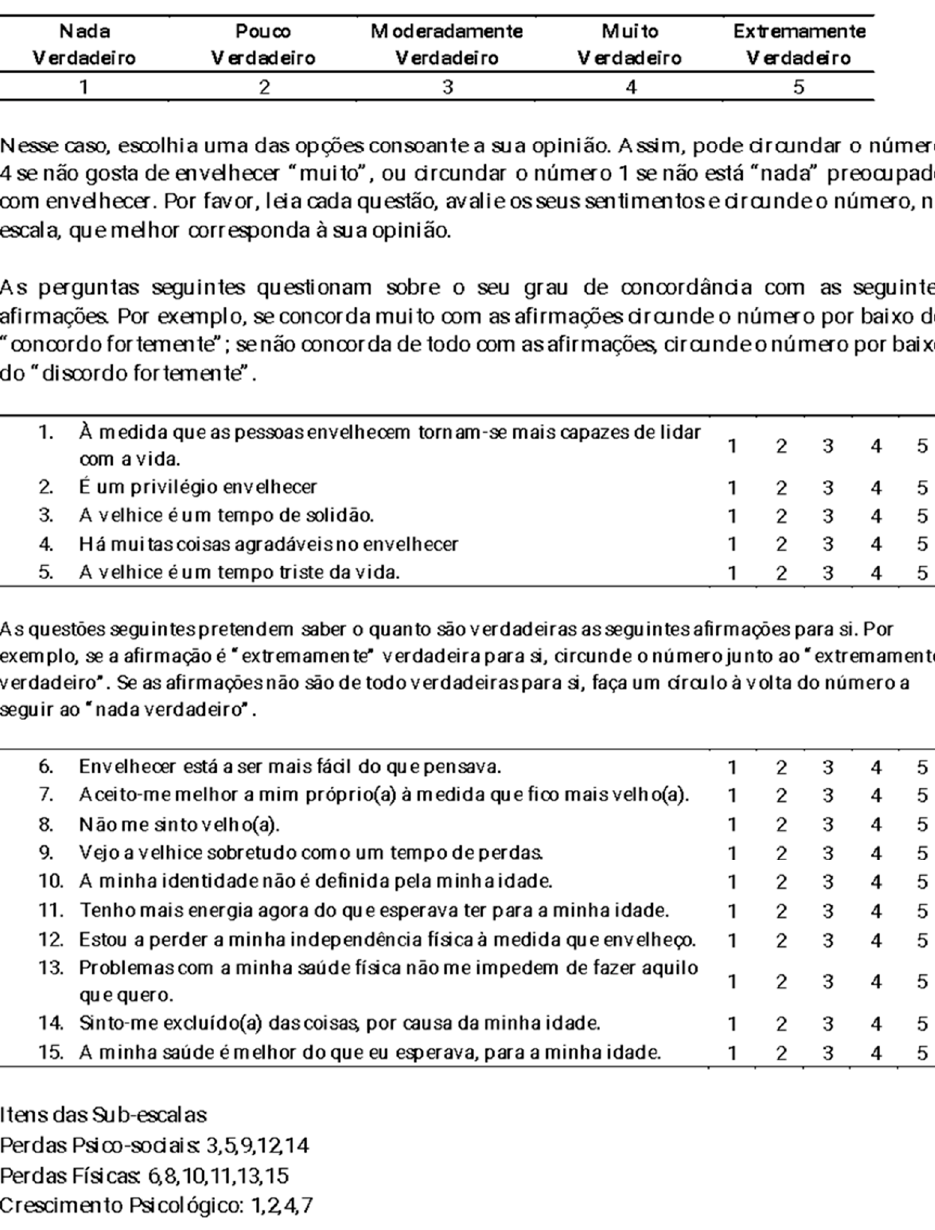
Figure A1. Portuguese Version of the Ageing Attitudes Questionnaire.